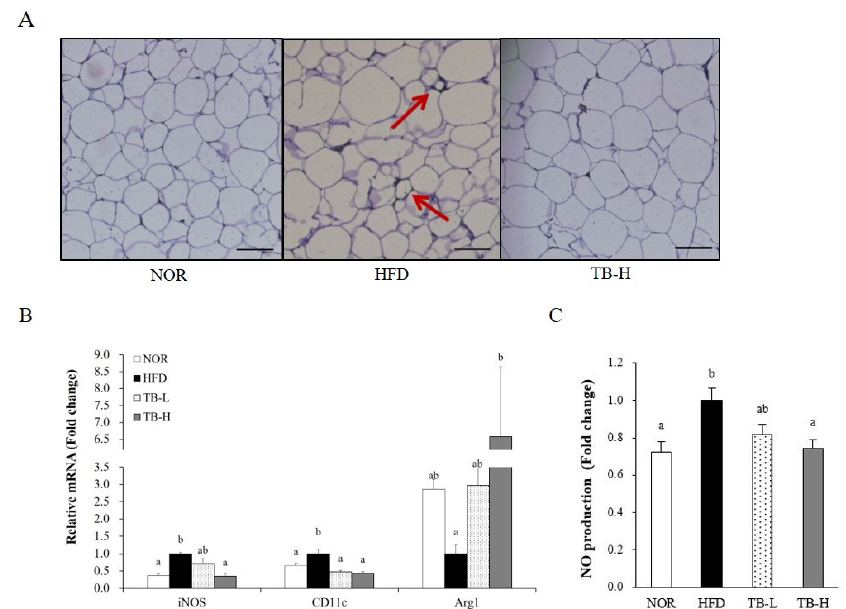
Figure 3. The effect of tartary buckwheat extract on adipose tissue macrophage infiltration and polarization. ( A ) F4/80 immunostaining of white adipose tissue, the arrows indicate crown-like structures. ( B ) mRNA level of M1 macrophage markers, inducible nitric oxide synthase (iNOS) and CD11c, and M2 macrophage marker, arginase 1 (Arg1). ( C ) NO production in rats fed experimental diets.